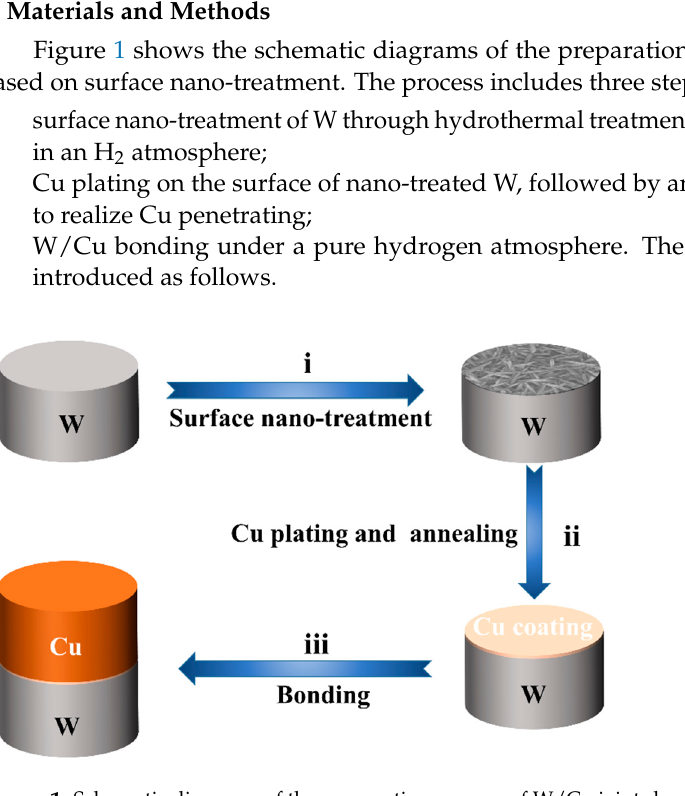
Figure 1. Schematic diagrams of the preparation process of W/Cu joints based on surface nano-